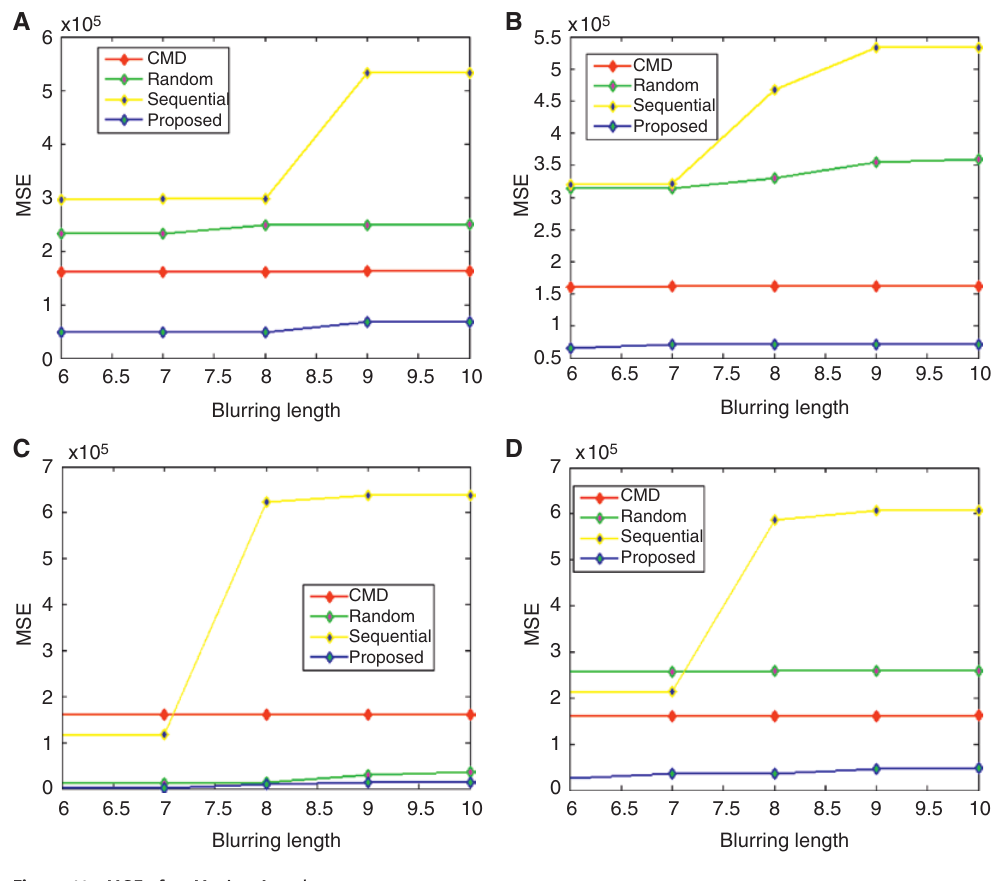
Figure 11: MSE after Motion